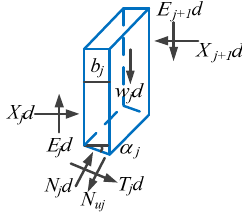
Figure 14. Force diagram of soil strip j. Soil strip on the left side of